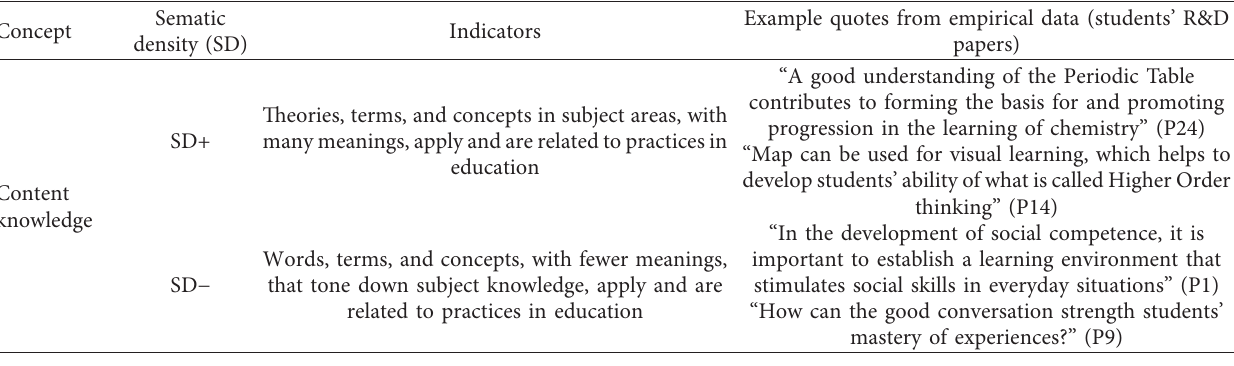
Table 2: An external language of description for semantic density (SD) in student papers.